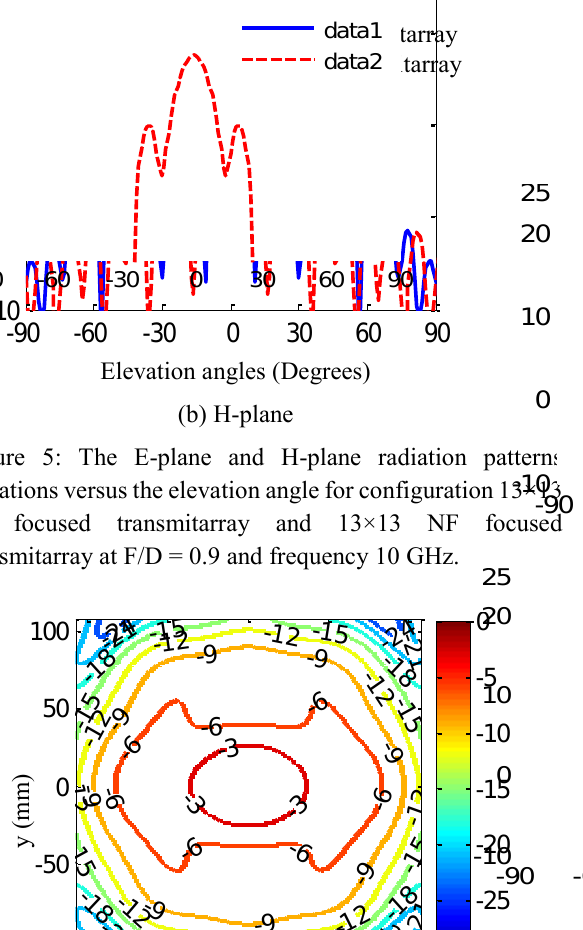
Figure 7: Simulated normalized power density along the transverse direction at R o = 310 mm for FF-focused transmitarray and NF-focused transmitarray from the antenna aperture (a) x = 0. (b) y =